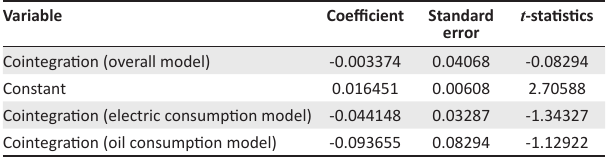
TABLE 4: Summary of Vector Error Correction Model estimates,